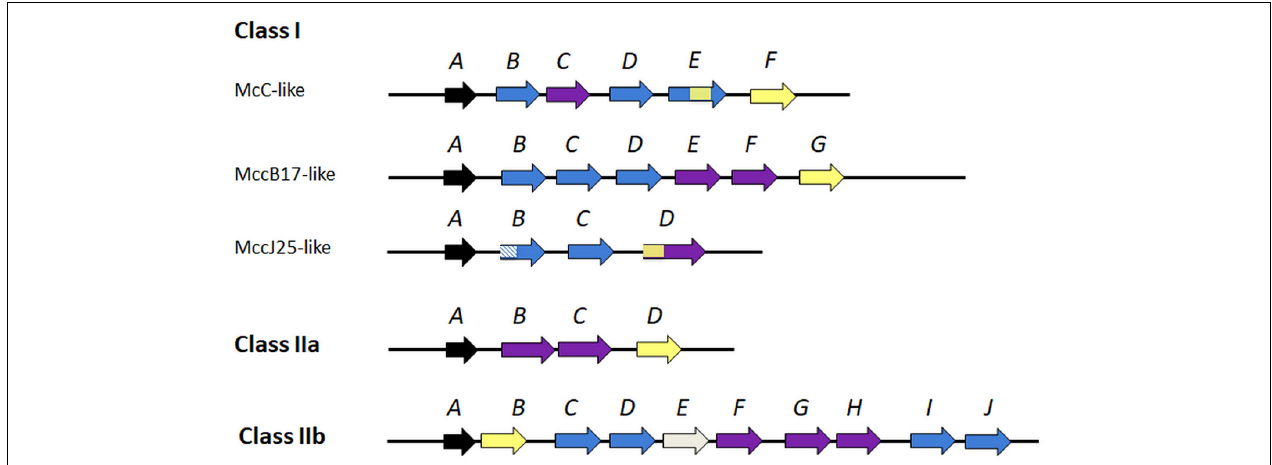
FIGURE 1 | A schematic representation of archetypical organization of microcin and microcin-like gene clusters. Arrows indicate individual microcin genes; arrows are not drown to scale and their direction does not necessarily indicate the direction of transcription that can change between homologous specific gene clusters. The A genes code for the precursors. Genes coding for microcin PTM enzymes and for export systems (efflux pumps, ABC exporters) that expel the microcins out of the producers are in blue and in violet, respectively. Genes whose products contribute to self-immunity of the producing strains (either immunity proteins or exporters/efflux pumps) are colored yellow. When genes code for proteins ensuring simultaneously two functions, they harbor the two corresponding colors. The gene coding for RRE, which ensures leader peptide recognition in MccJ25 and MccJ25-like peptides is shown as hatched motif. The functions of the different PTM enzymes are indicated as follows, taking McC, MccB17, MccJ25 and MccE492 as models. McC and analogs: mccB product ensures MccA adenylation, mccD- and mccE- encoded enzymes (MccD and MccE N-terminal domain) are required for phosphate modification with propylamine; MccB17 and analogs: mcbBCD- encoded three-component synthetase catalyzes dehydration and cyclization to form azolines, which are subsequently oxidized to azoles; MccJ25 and analogs: mcjC product acts as a lasso cyclase that closes the macrolactam ring through an isopeptide bond and mcjB product is a leader peptidase; MccE492 and siderophore peptides: mceCDIJ are required for PTM with mceC encoding a glycosyltransferase that ensures glycosylation of enterobactin and mceD an enterobactin esterase that cleaves the glycosylated enterobactin macrolactone ring into its linear derivatives. mceIJ are involved in attachment of the PTM to MccE492 C-terminus. The function of mceE gene (gray) is